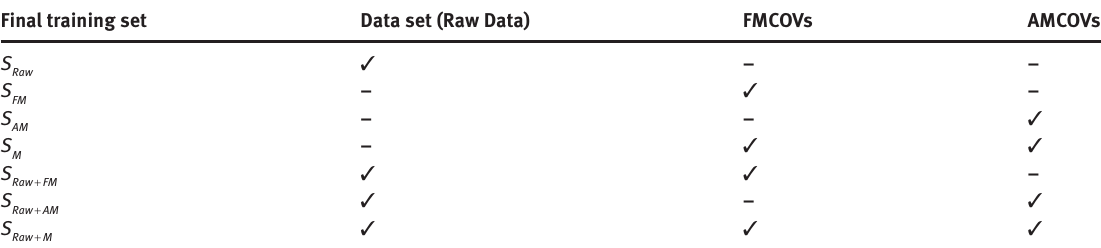
Table 4: Components of the Final Training Sets. Final training